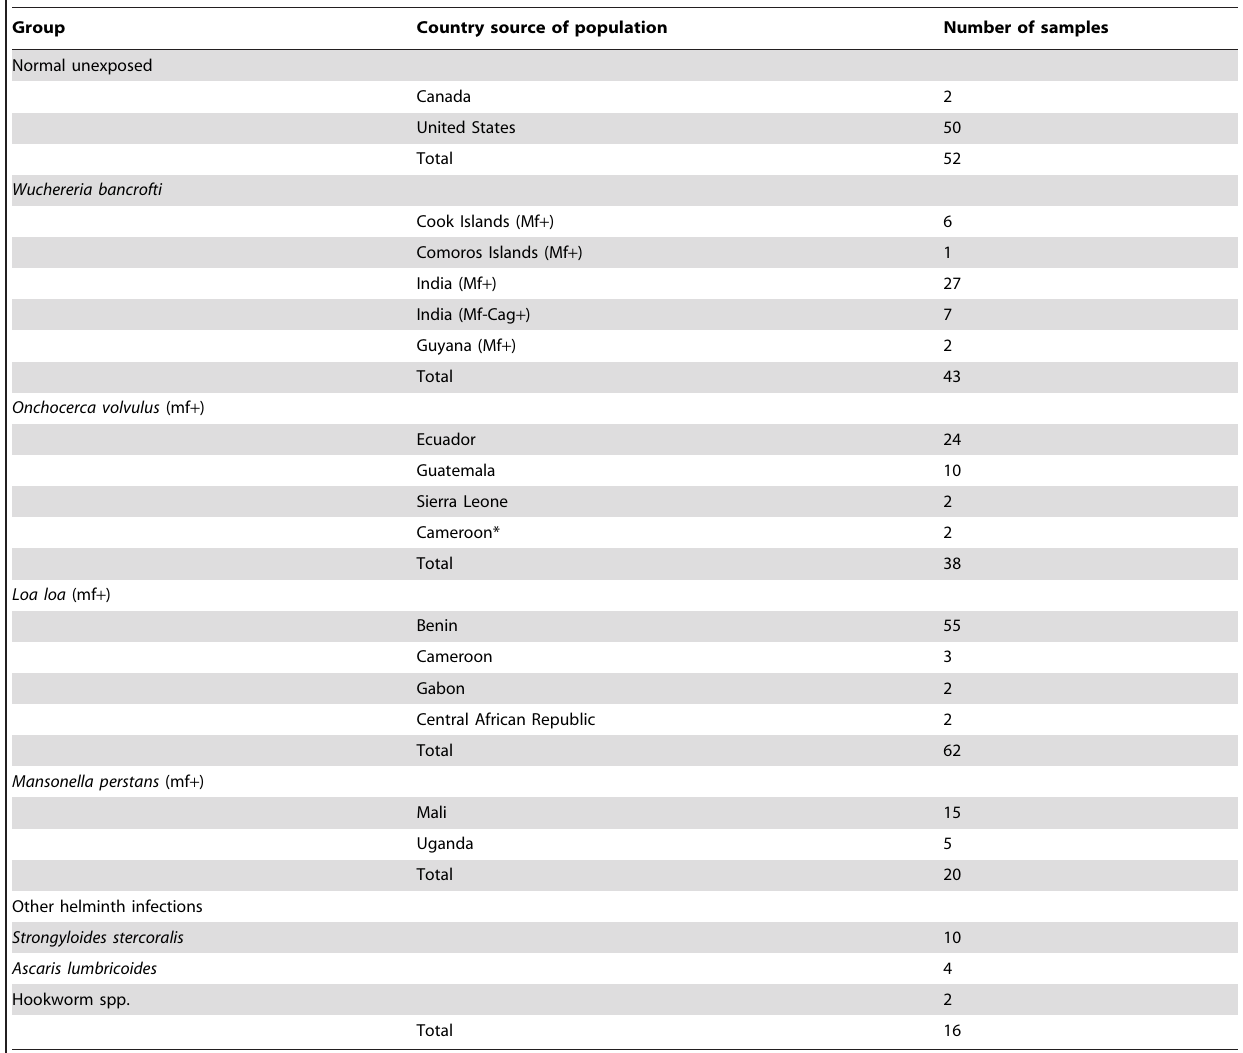
Table 1. Samples used to assess sensitivity and specificity of Wb123 LIPS.